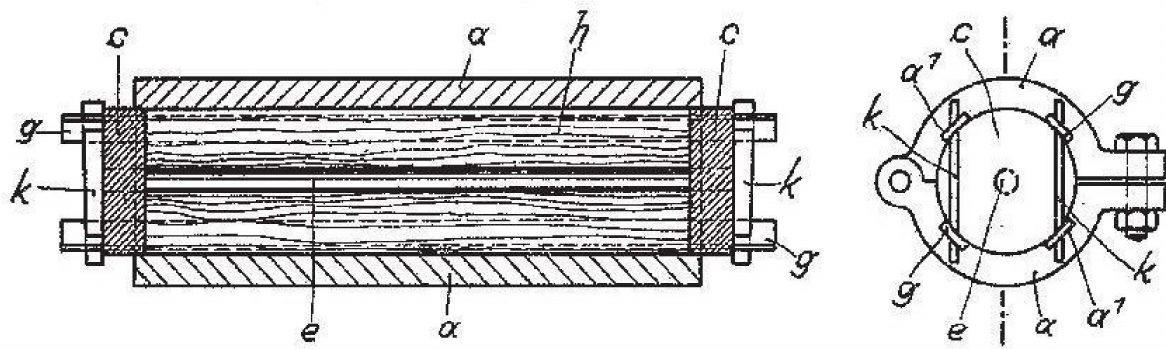
Figure 4. Sections of a machine that is able to compress cylindrical wood in its longitudinal direction. Reproduced from [52]. Abbreviations: a—case; a 1 —groove; c—press plate; e—core hole; g—mounting stem; h—workpiece;